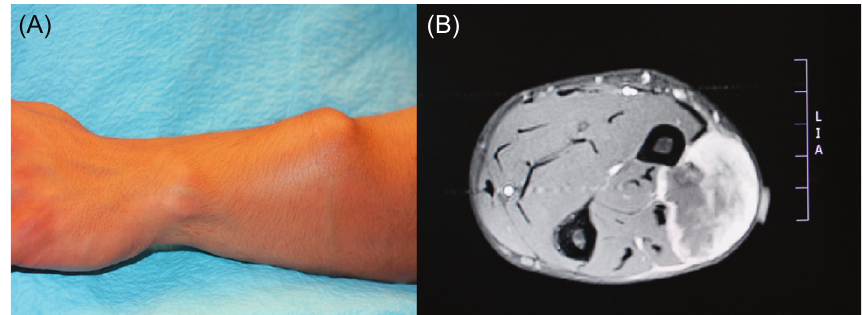
Figure 2. Twenty-three-year-old male with extraosseous rhabdomyosarcoma. The patient was being prepared for induction chemotherapy. The use of neoadjuvant chemotherapy was unanimously preferred by both medical and surgical members of the multidisciplinary team. The decision regarding the type of reconstruction was deferred and made dependent on the response to the neoadjuvant therapy. The patient succumbed to the disease while in